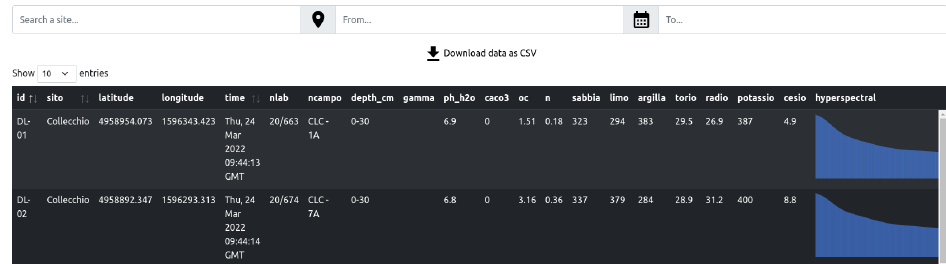
Figure 4. Closeup of the Tabular interface. Each sample is identified through an id and spatially located by its GPS coordinates. Each sample is characterized by its soil properties and by its hyper- spectral signal, which were reported graphically for a better user